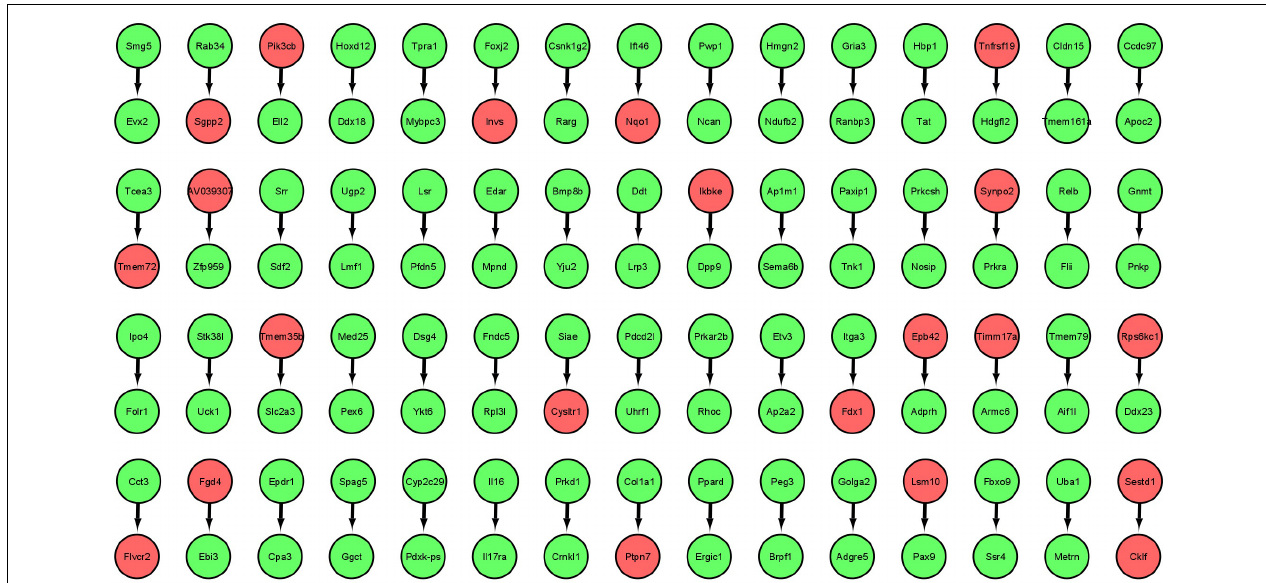
FIGURE 2 | Markov Blanket Gene Regulatory Network for GLDS-246 dataset. Red colored circles are genes with higher regulatory activity selected for constructing the GDKG.